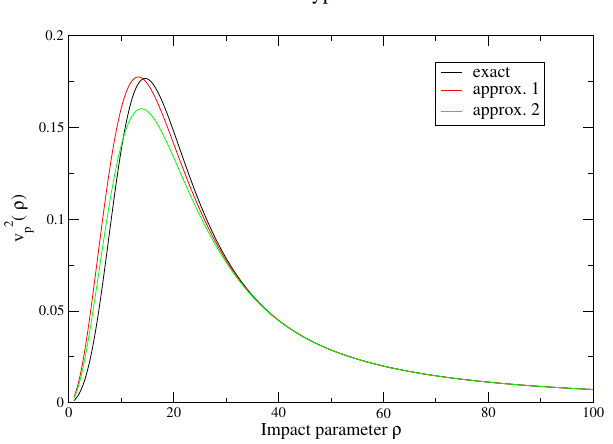
Figure 6. Atomic schemes corresponding to diagonal terms of the collision operator (type III).